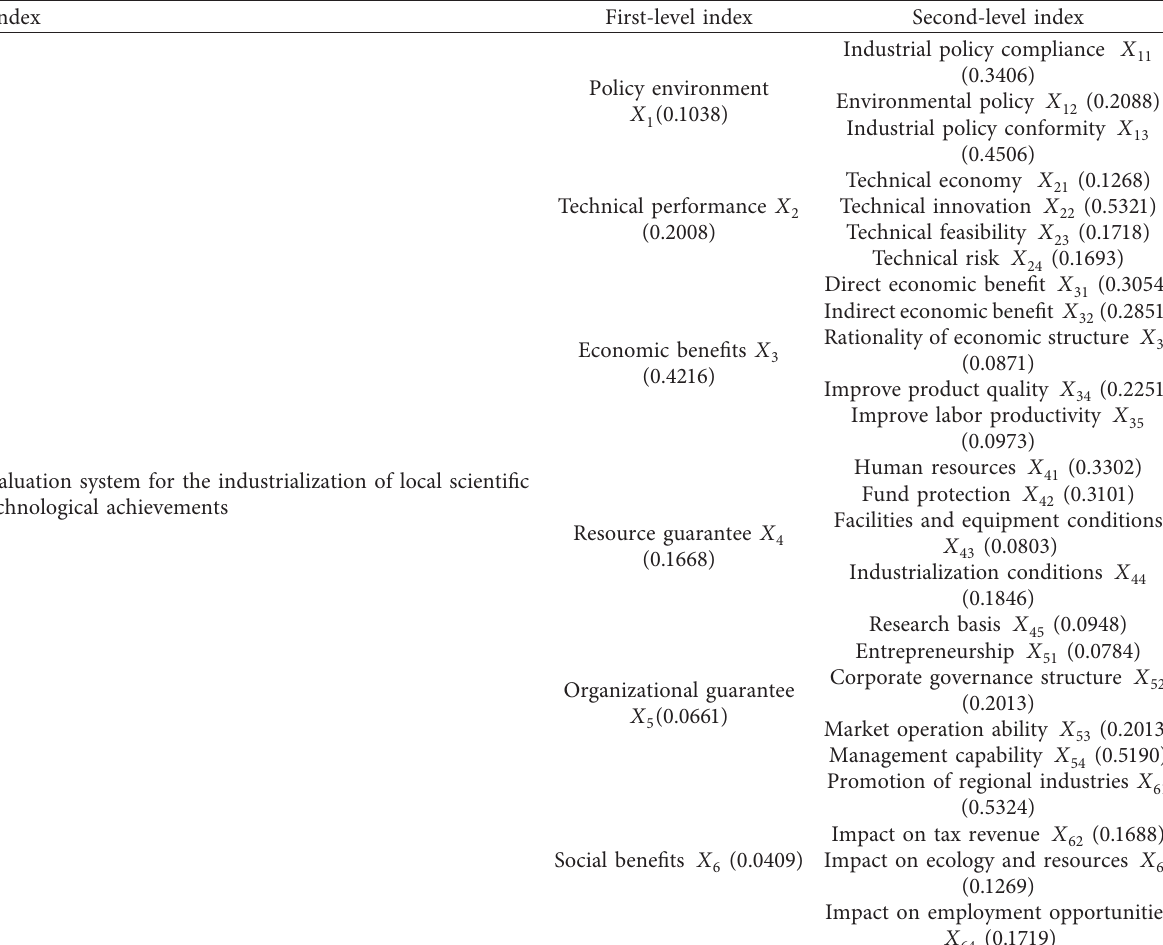
Table 2: Pre-evaluation index system of local sci-tech achievement industrialization project.